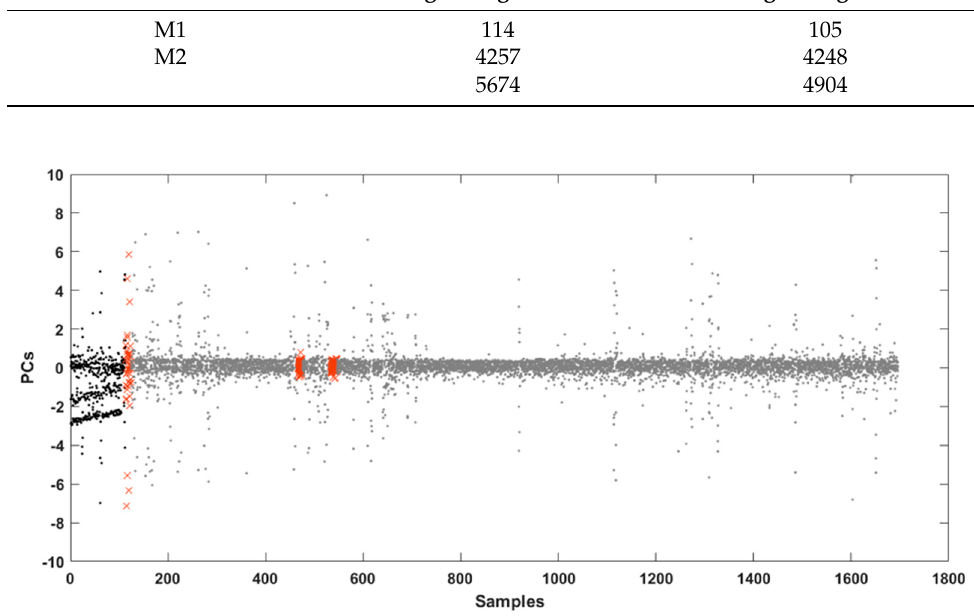
Figure 11. Results of the AAD + ADP algorithm (extruder-M1).